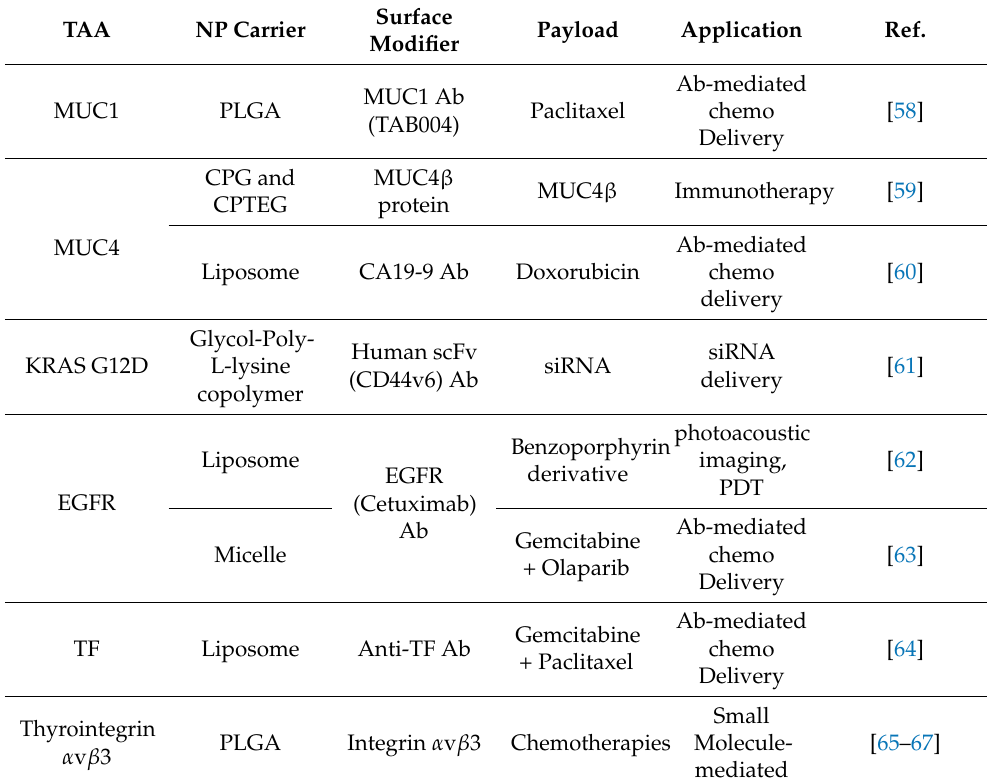
Table 5. Tumor-associated antigens for the delivery of therapeutic payloads in